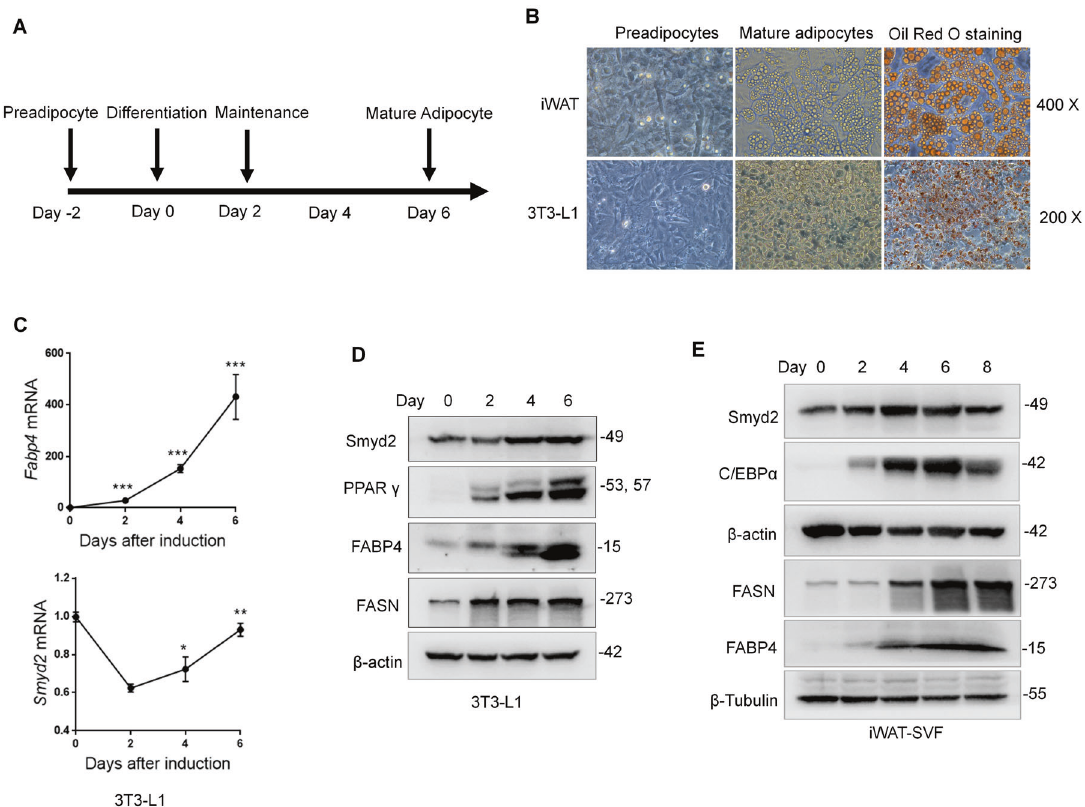
Fig. 2 Smyd2 is closely correlated with adipocyte differentiation in vitro. A The schematic outline of experimental procedures for adipocyte differentiation. B 3T3-L1 cells and iWAT-SVF were differentiated into mature adipocytes, as detected by both the bright fi eld of microscopy and the Oil Red O staining. Magni fi cation ×400 and ×200. C The mRNA levels of Smyd2 and the adipocyte marker gene ( Fabp4 ) were examined during 3T3-L1 cell differentiation by RT-qPCR analysis. D, E The protein expressions of Smyd2 and adipocyte differentiation markers (PPAR γ , FABP4, FASN, and CEBP α ) during 3T3-L1 cells and iWAT-SVF differentiation were detected by immunoblot analysis. Data are presented as mean ± SD. * p < 0.05, ** p < 0.01, *** p <